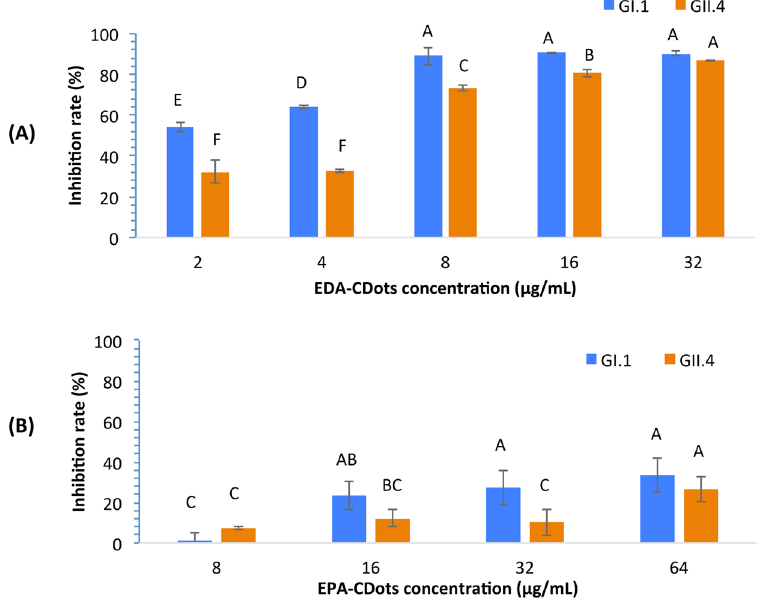
Figure 3. Inhibition effects of EDA-CDots and EPA-CDots on GI.1 and GII.4 VLPs’ binding to their respective antibodies. ( A ) EDA-CDots and ( B ) EPA-CDots. Statistic analysis was performed using SAS 9.2. Different letters on the columns indicate significant differences at P < 0.05, while the same letters indicate no significant difference.